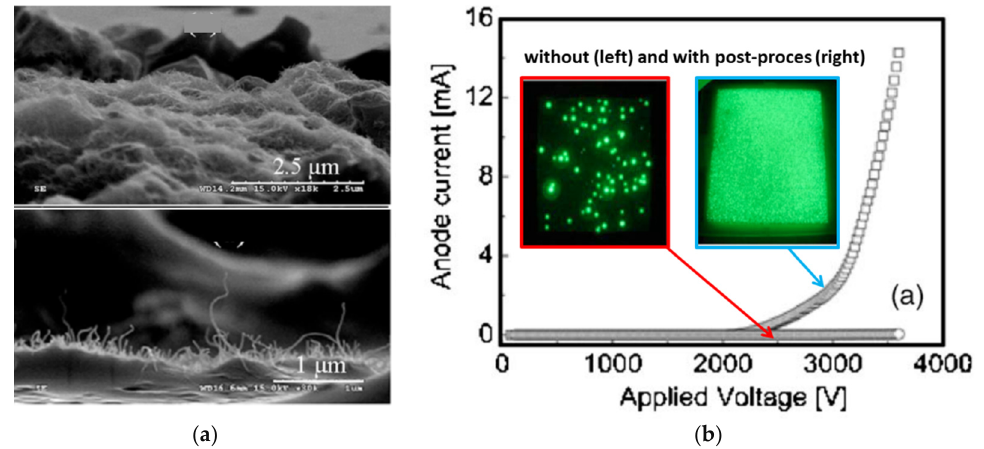
Figure 15. Emission enhancement by a postprocess treatment: ( a ) SEM images of the printed CNT films before (upper view) and after (lower view) postprocess treatment; ( b ) I–V characteristic of the cathode before and after postprocess treatment with the inset, showing emission images of the relevant cathodes reprinted with permission from [139].